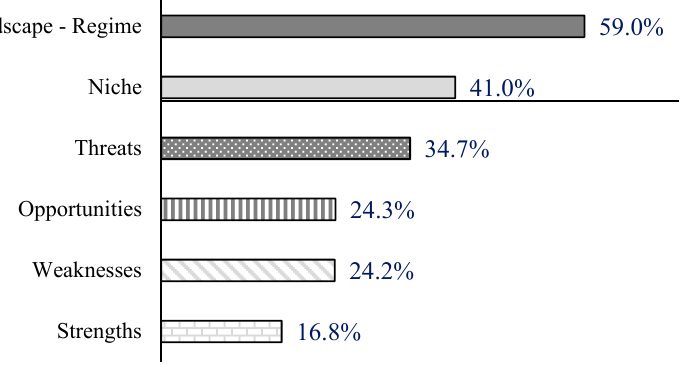
Figure 4. Priority levels of SWOT-MLP factors. Source: author.